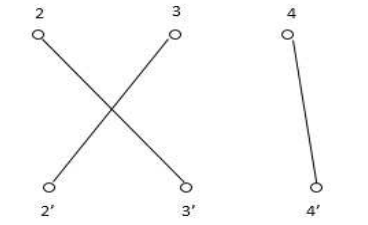
Figure 3. The signed constrained 3-matching { ( 2,3 (cid:48) ) , ( 3,2 (cid:48) ) , ( 4,4 (cid:48) ) }